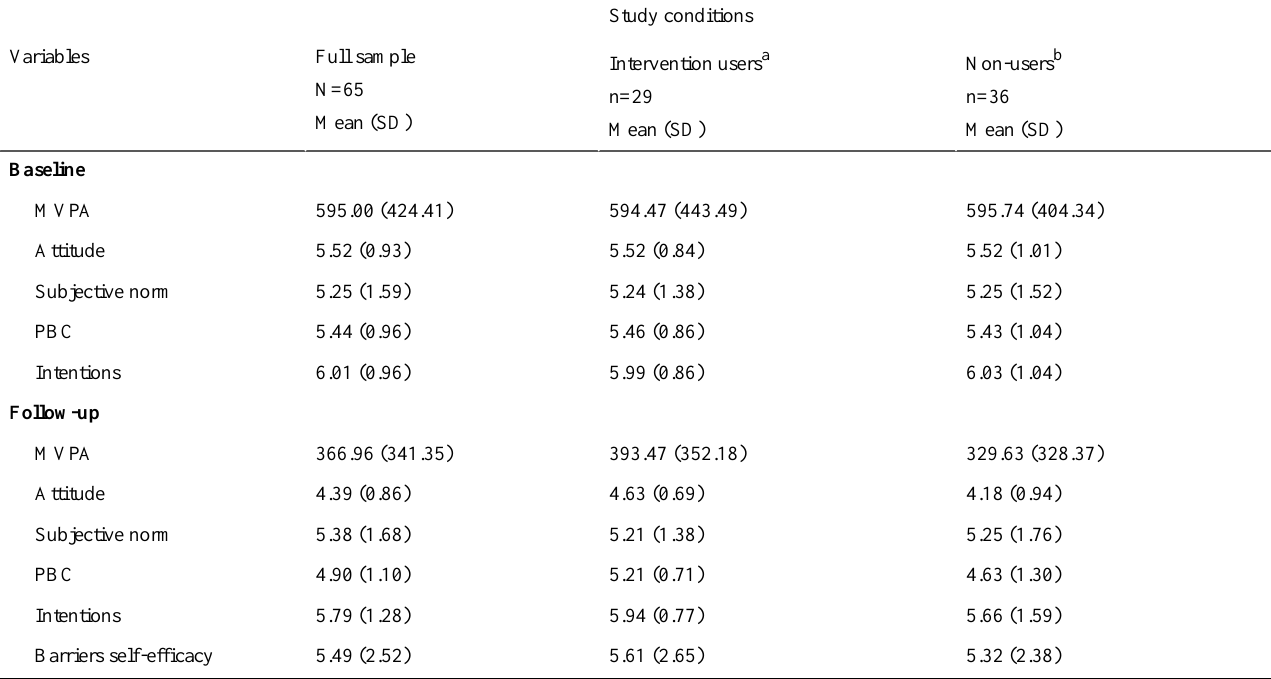
Table 1. Descriptive statistics of physical activity behaviors and cognitions by study condition.